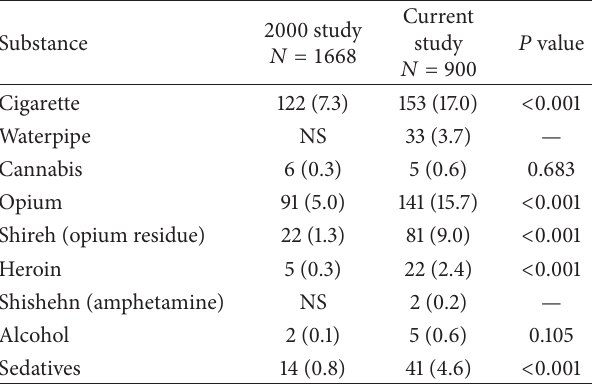
Table5:Prevalence(%)ofdailysubstanceuseamongruralresidents in 2000 and